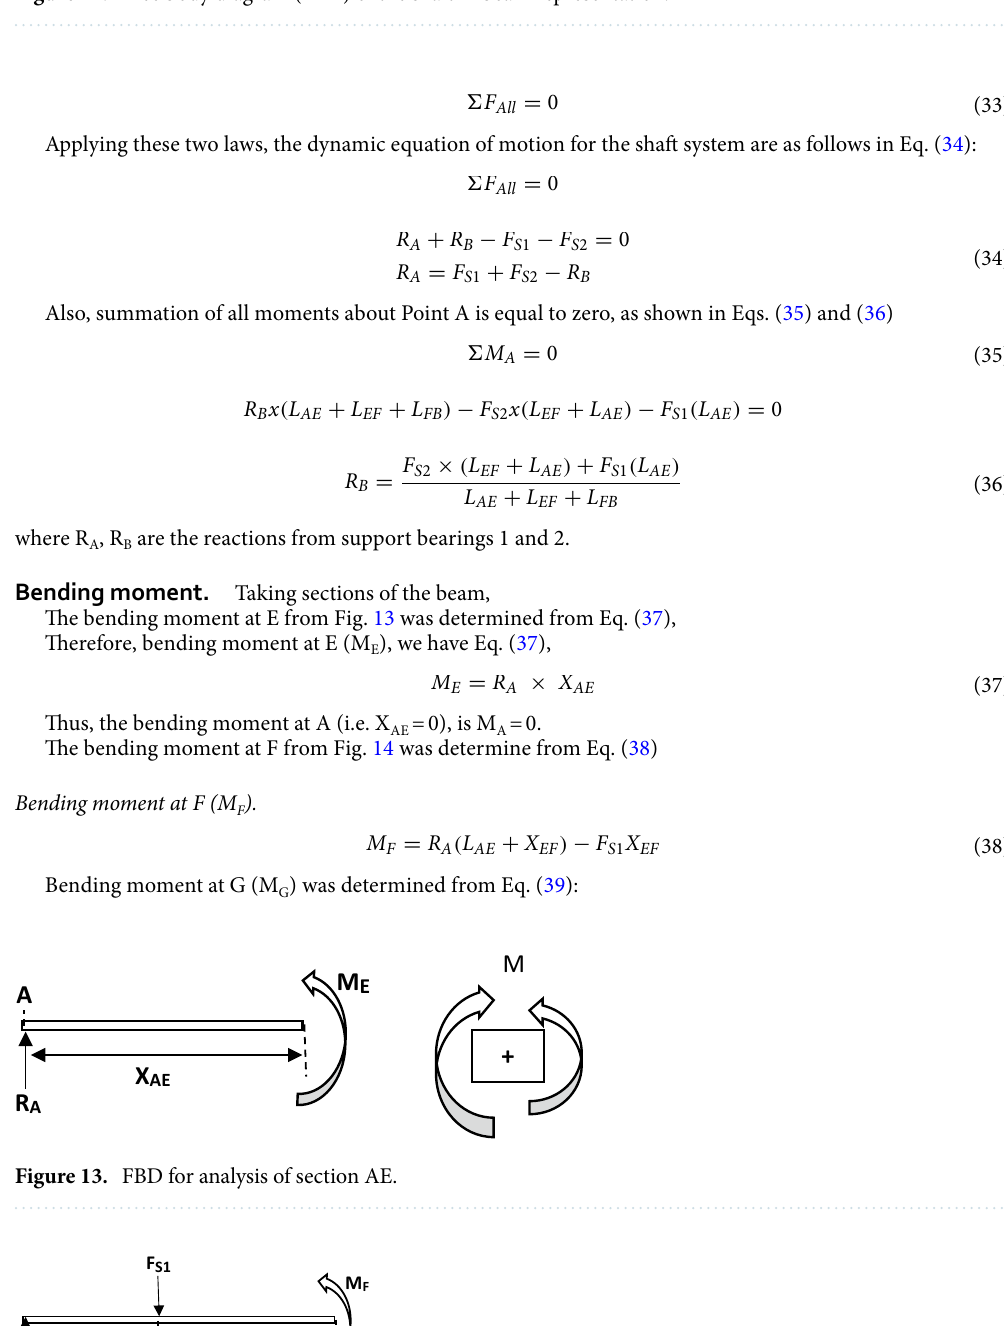
Figure 12. Free body diagram (FBD) of the shaft in beam representation.